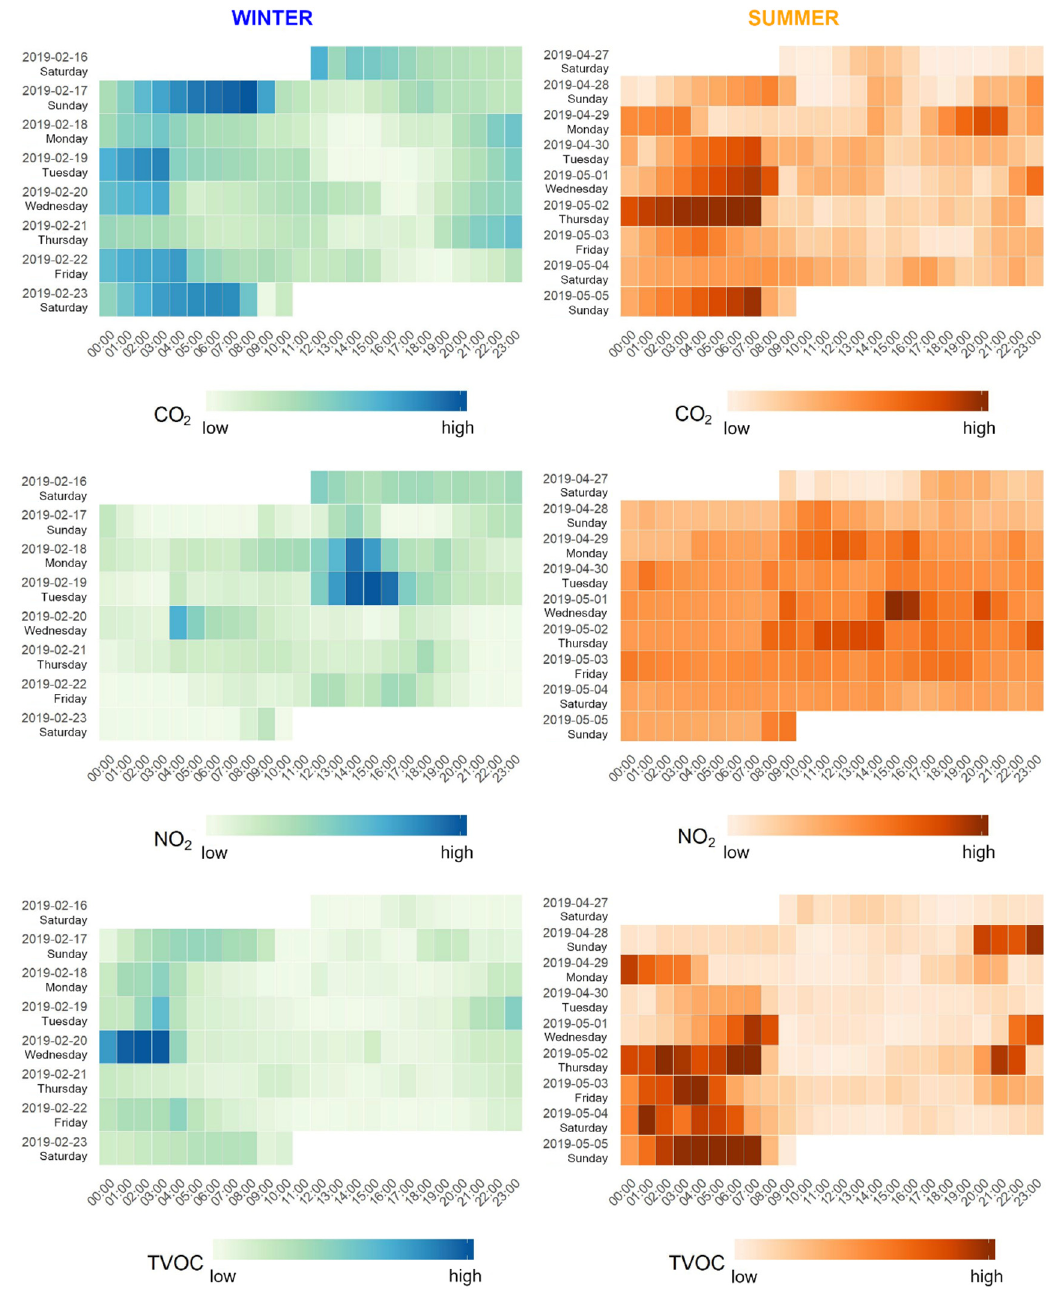
Figure 3. Faceted heatmaps of three pollutants (CO 2 , NO 2 , and TVOCs); data from